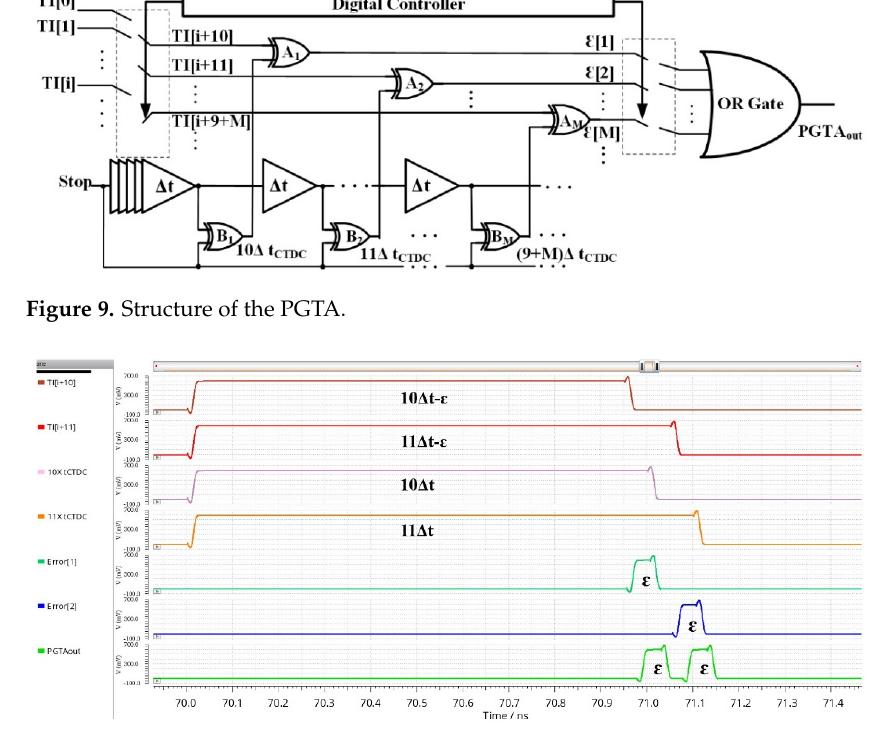
Figure 10. Simulated time diagram of the PGTA at M = 2.